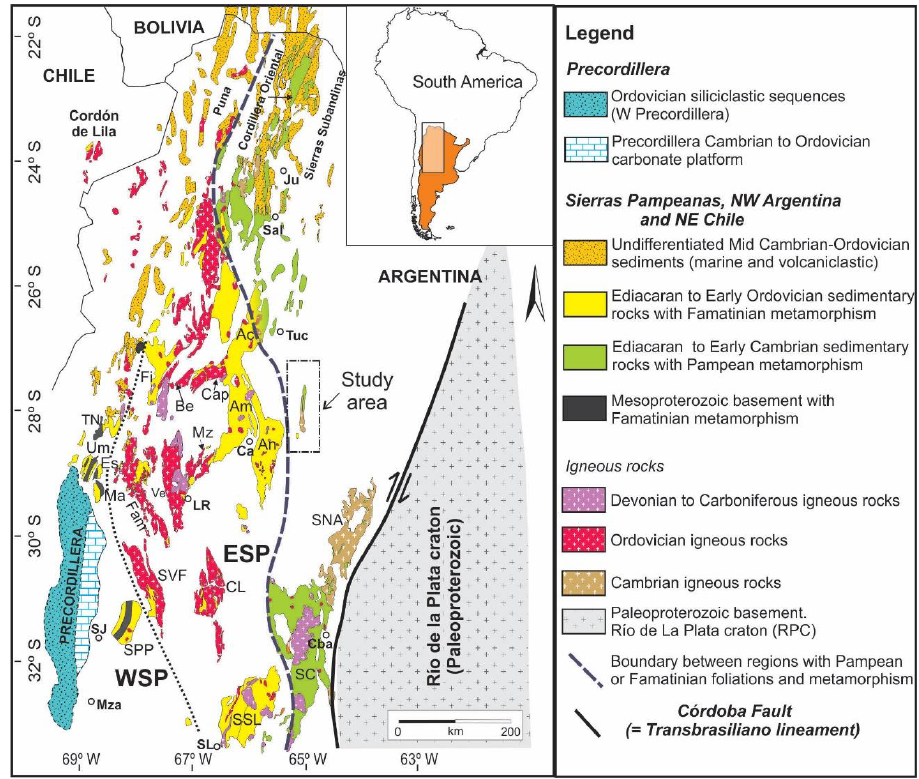
Figure 1. Early Paleozoic geology of the Sierras Pampeanas, Precordillera, Puna, Cordillera Oriental and Sierras Subandinas. EPEB: Eastern Puna Eruptive Belt. Main ranges are indicated: Sierra de Aconquija (Ac), Sierra de Ambato (Am), Sierra de Ancasti (An), Sierra de Bel é n (Be), Sierra de Capillitas (Cap), Sierra del Espinal (Es), Sierra de Famatina (Fam), Sierra de Fiambal á (Fi), Sierras de Chepes-Los Llanos (CL), Sierra de Maz (Ma), Sierra de Maz á n (Mz), Sierra de C ó rdoba (SC), Sierra Norte-Ambargasta (SNA), Sierra de Pie de Palo (SPP), Sierra de San Luis (SSL). Sierra del Toro Negro (TN), Sierra de Valle F é rtil (SVF), Sierra de Velasco (Ve), Sierra de Umango (Um). Town localities: Jujuy (Ju), Salta (Sal), Tucum á n (Tuc), Catamarca (Ca), La Rioja (LR), San Juan (SJ), C ó rdoba (Cba), Mendoza (Mza), San Luis (SLo). Modified from Rapela et al.